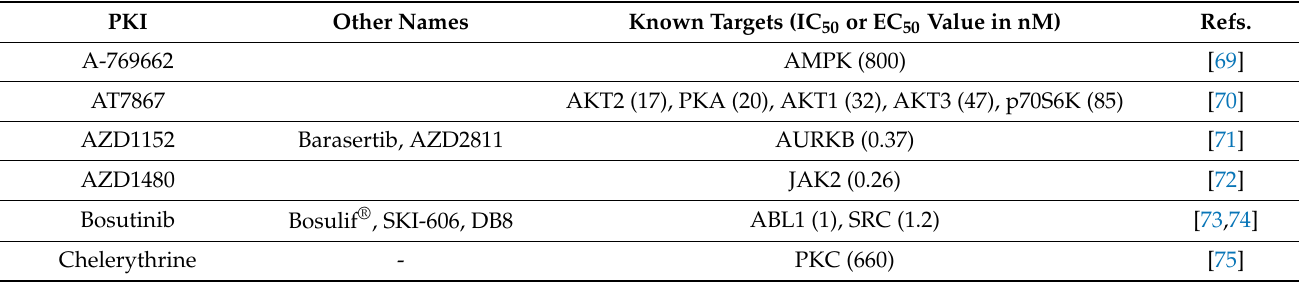
Figure 1. Identification of IKK16 as a synergistic partner of gefitinib for anticancer activity in MDA- MB-231 cells. ( A ) The number of points with CI values greater than 1.3 and the mean CI values for these points are depicted. IKK16 was identified as a strong potentiator of gefitinib. The dashed lines indicate the thresholds for selection ( x = 4.8 and y = 1.5, respectively. CI, classification index (see Materials and Methods). ( B ) The MTT screening results for IKK16 in combination with gefitinib in MDA-MB-231 cells. Table 1. PKIs identified from the